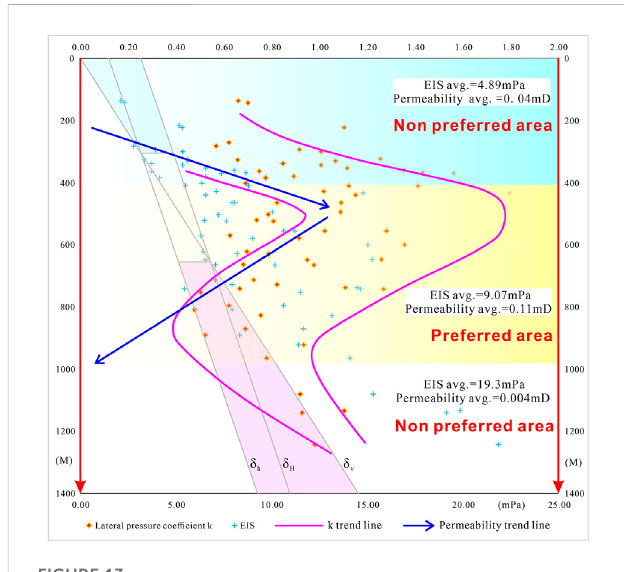
Classi fi cation of the longitudinal coalbed methane development potential in western Guizhou (the blue arrow represents the trend of permeability, the purple line corresponds to the trend of lateral pressure coef fi cient, depicting its upper and lower limits. The left background of the fi gure shows the trend of triaxial principal stress with